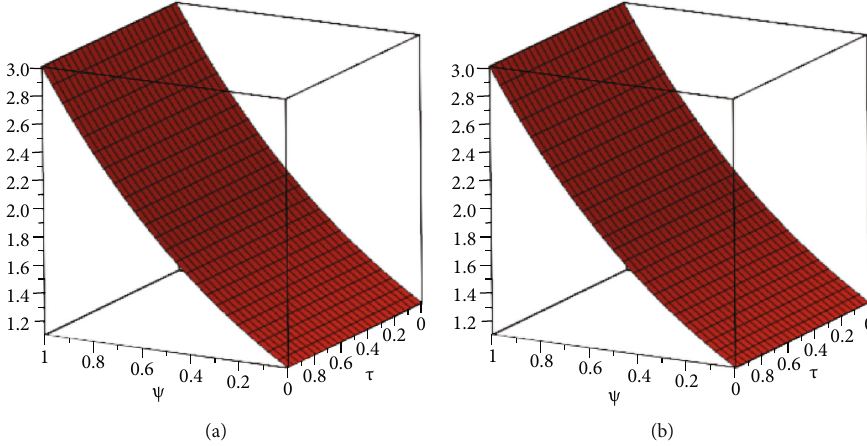
Figure 1: Example 1 solution graph. (a) Exact solution and (b) analytical solution at σ = 1